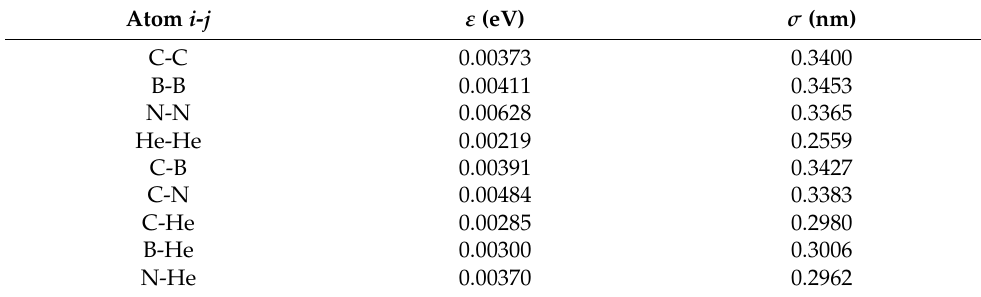
Table 2. Lennard-Jones parameters for the interatomic van der Waals